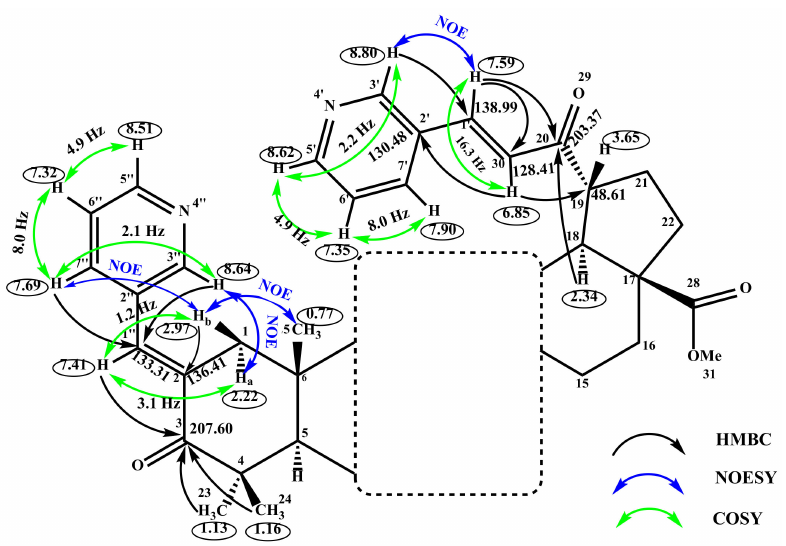
Figure 4. HMBC, COSY, and NOESY correlations for compound 7 .